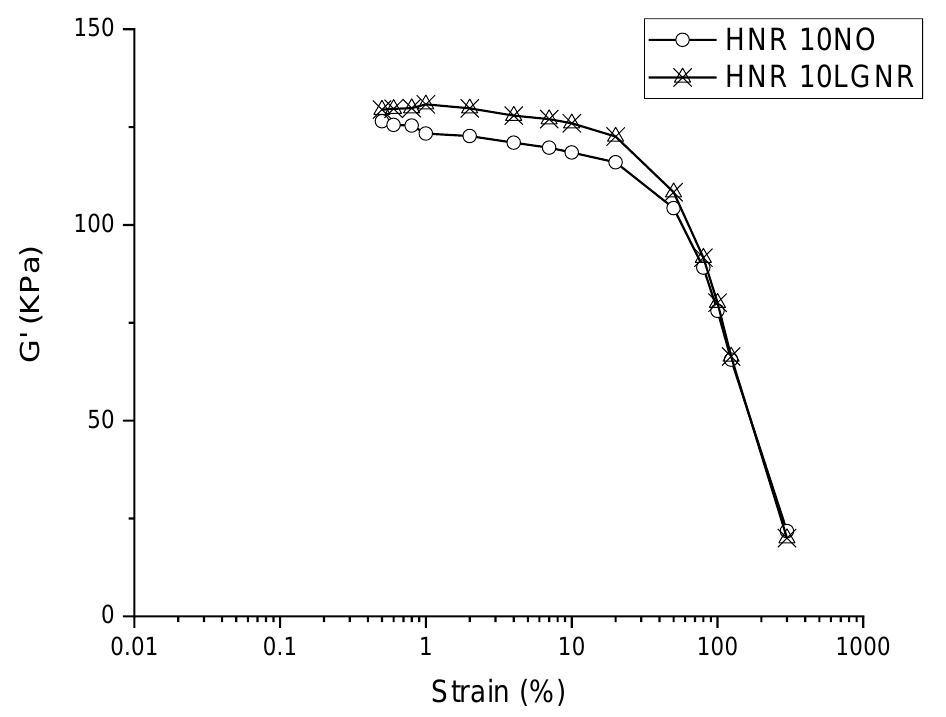
Figure 2. Storage modulus (G’) of unfilled Hevea natural rubber (HNR) compounds with LGNR or NO from 0.5% to 300% strain amplitude. 10NO: rubber compounds with 10 phr naphthenic oil; 10LGNR: rubber compounds with 10 phr liquid guayule natural rubber.